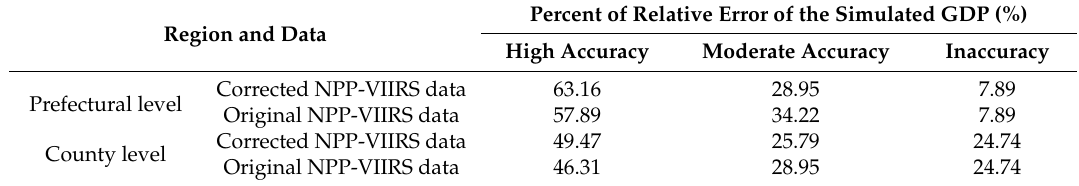
Table 2. Accuracy at different levels of the simulated GDP.